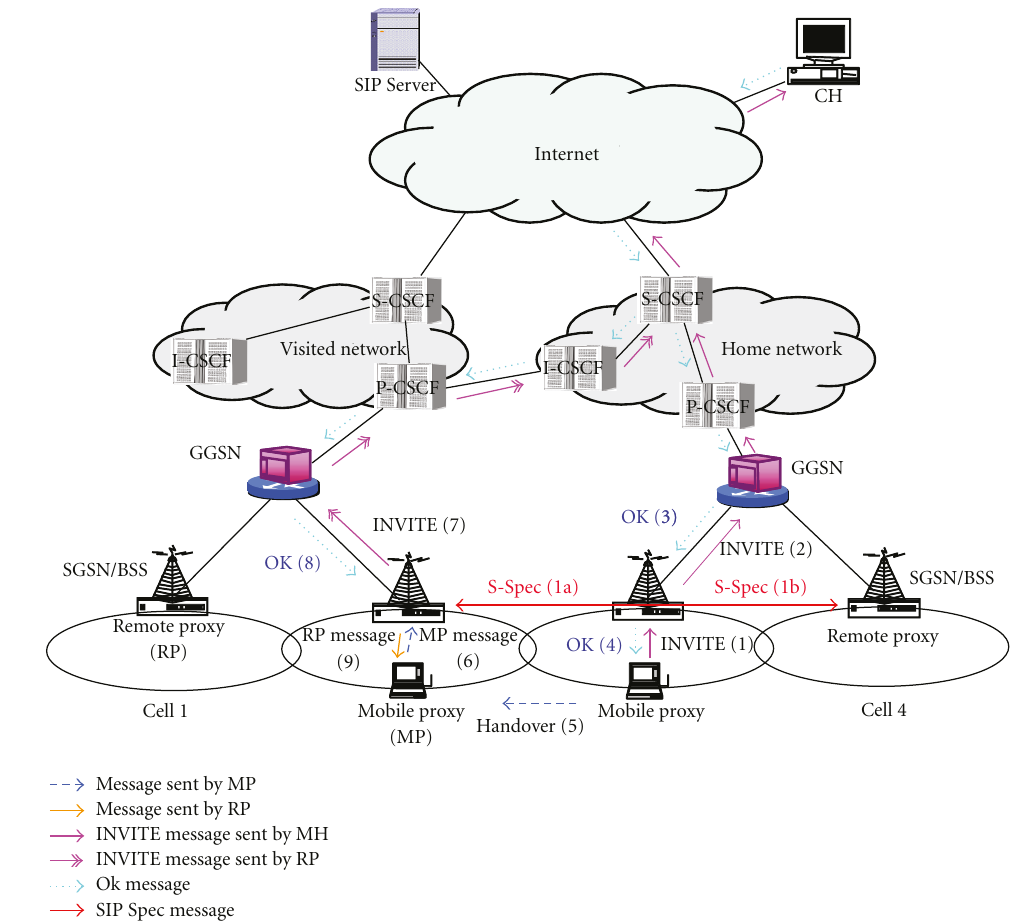
Figure 2: SIP Session re-Setup by a remote proxy on behalf of